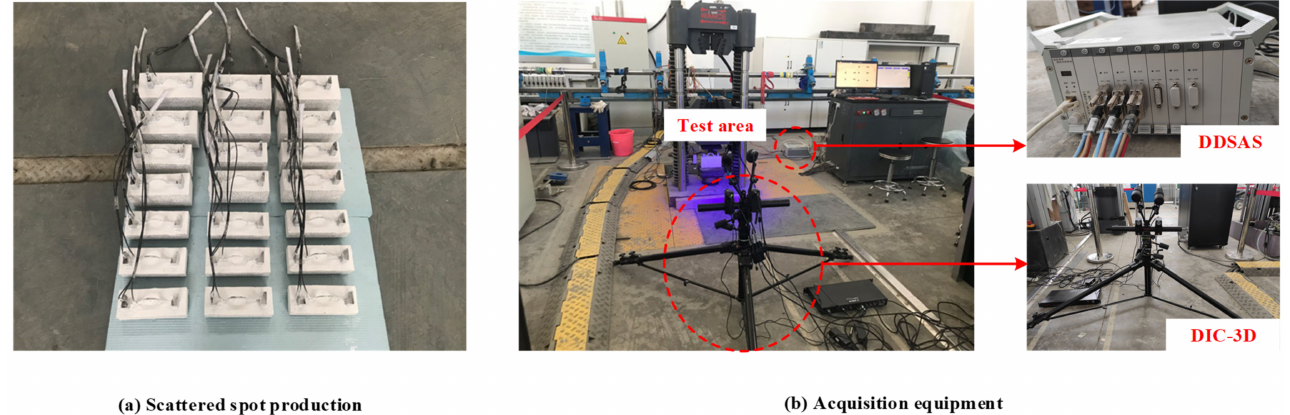
Figure 6. Acquisition layout